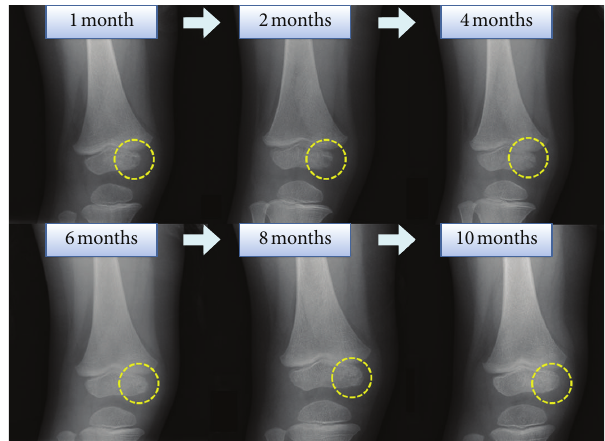
Figure 4: Radiograph at 1 month after onset of disease shows the radiolucency in the medial epiphyseal nucleus. Radiograph at 4 months shows the start of remodeling the epiphysis. Radiograph at 10 months returns almost normal